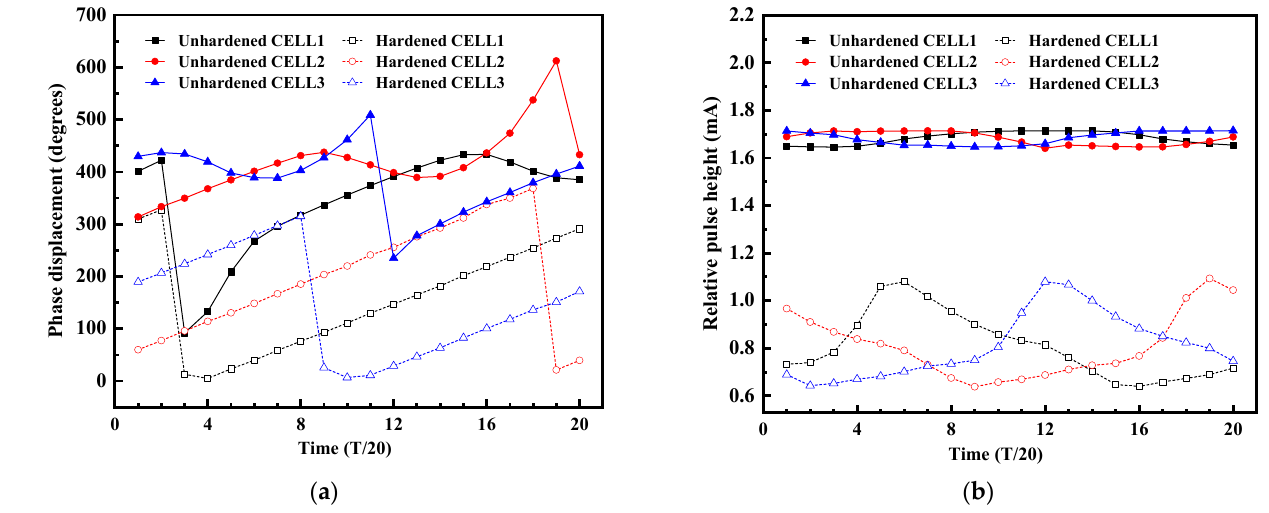
Figure 13. Performance comparison results of the three delay cells at different times in the same cycle before and after hardening. ( a ) Comparison result of the phase error. ( b ) Comparison result of the SET current pulses.